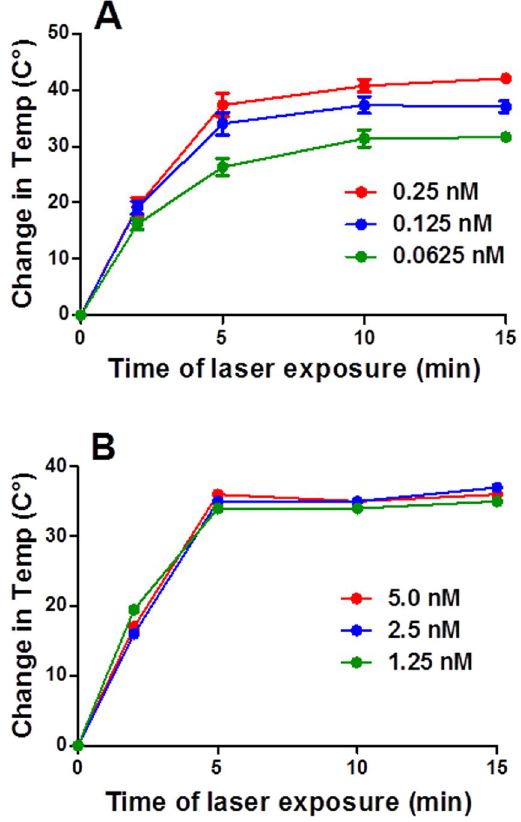
Figure 8. Temperature change induced by photothermal heating of ( A ) PEG-GNR and ( B ) PS-GNR at different molar concentrations and increasing NIR laser exposure times. All initial temperatures were 21 ± 0.5 °C in solutions and 19.2 ± 0.6 °C on agar plates. The standard deviations in ( B ) are very Synthesis and characterization of CTAB capped GNR (CTAB-GNR), PEG-GNR, and PS-GNR.